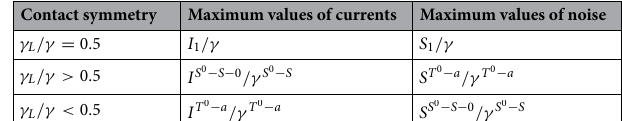
Figure 11. Tunneling current as a function of Coulomb interaction ( 2 U /γ S ) for a single-level in the quantum 0 0 /γ S S 0 channel 2 I S 0 S dot I 1 /γ (black curve), for the S (red dashed curve) and for the T − − − − 2 I T 0 a /γ S (blue dashed-dotted curve) for symmetric coupling between the left and right leads. I T 0 a /γ T 0 a = Temperature is equal to 0.01 ε .